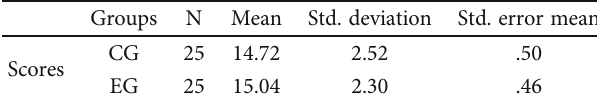
Table 1: Descriptive statistics of the idiom